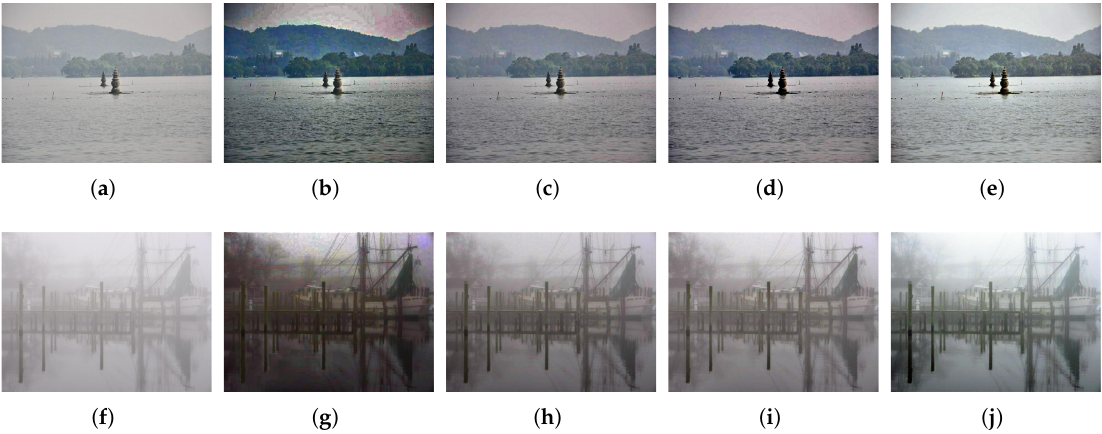
Figure 12. Examples of color cast. ( a , f ) Two hazy images. ( b , g ) Generated by DCP. ( c , h ) Generated by DehazeNet. ( d , i ) Generated by MSCNN. ( e , j ) Our results. Compared with DCP, DehazeNet and MSCNN, our method effectively corrects the color cast phenomenon and produces a visual better